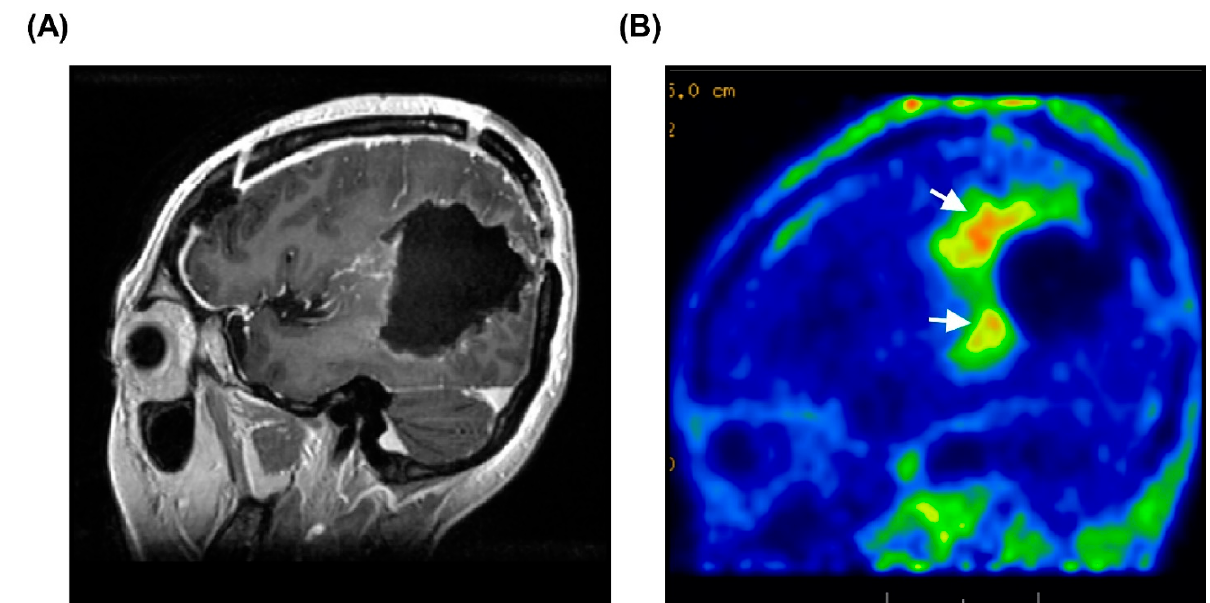
Figure 6. Invisible tumor activity revealed by 18F-BPA-PET. ( A ) MRI of patient after surgical resection of brain tumors. Postoperative MRI did not identify overt lesions after surgery. ( B ) Postoperative 18F-BPA-PET revealed strong tumor activity in the surgical margin. The white arrows indicate the infiltrative tumor lesions.